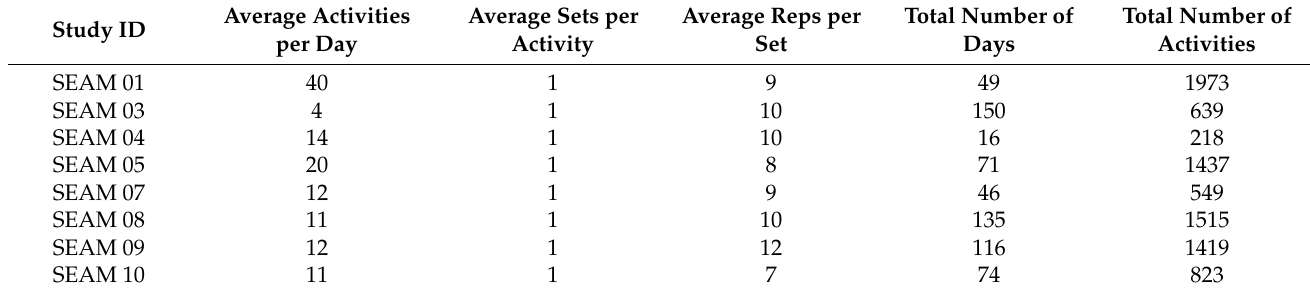
Table 4. Patient prescriptions quantified as the average number of activities prescribed per day, the average number of sets prescribed per activity, the average number of repetitions prescribed per activity, the total number of days the system was in use, and the total number of activities prescribed over usage of the system. Therapists prescribed exercises to their patients every day except for SEAM 07 who was not prescribed exercises on Sundays.